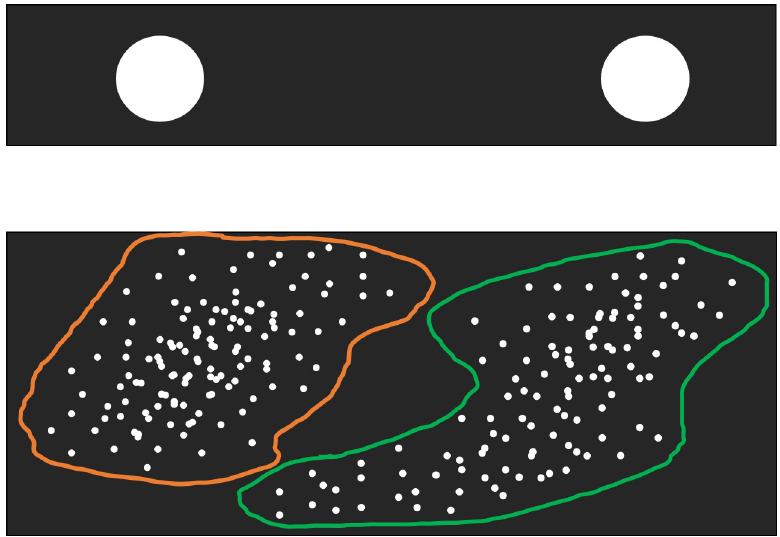
Figure 1. The primary neural field (below) and senior neural field (above) of NMIS. There are two subpopulations in the primary field, which correspond to two SNs. The white ones are IPNs (in the primary field) and ISNs (in the senior field). All of them are implicit until the inter-field connections are